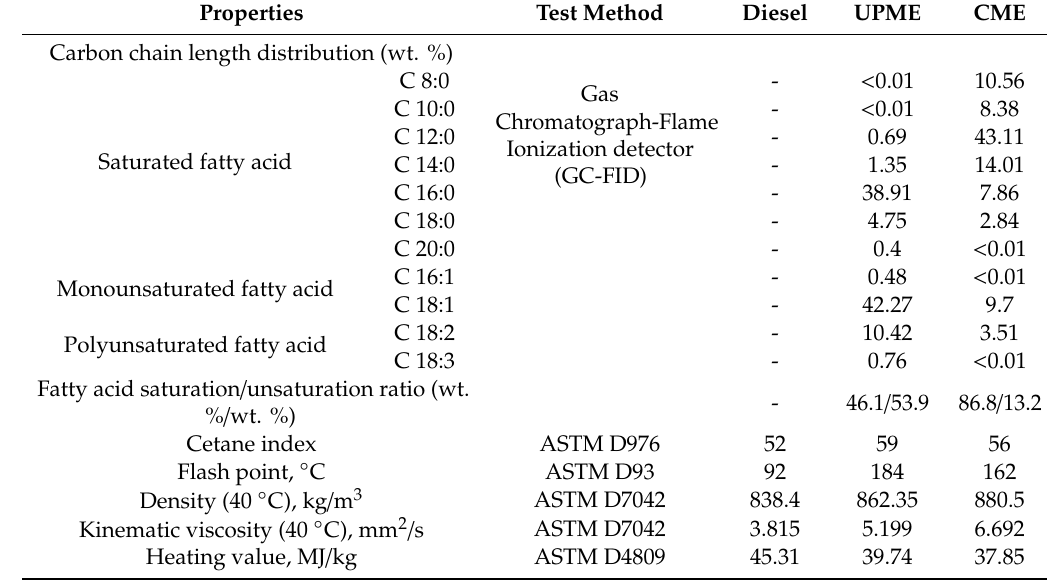
Table 1. Physiochemical properties of the methyl ester and diesel fuel.